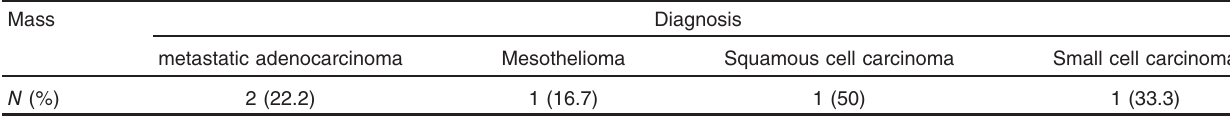
Table 7 Different pathological subtypes of gross mass picture among studied patients Mass